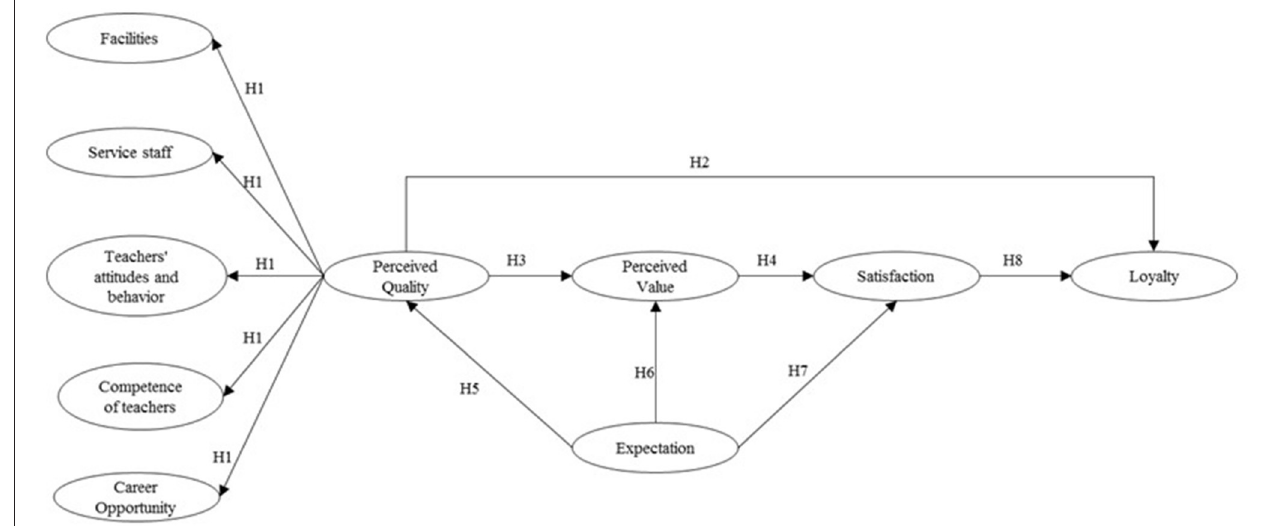
FIGURE 1 | Theoretical model and